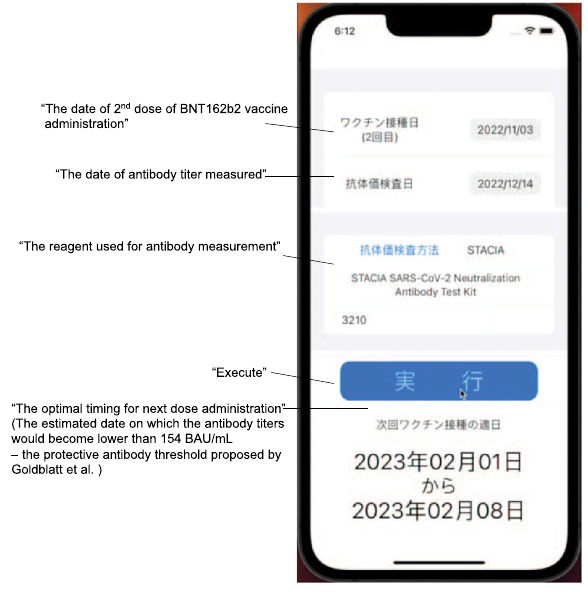
Fig. 4 Prototype of antibody simulation application using model. Screen image of the iOS application named “ COVID Vaccine Navi. ” Information about the date of vaccination singly measured antibody titer, and estimated date of negative seroconversion is presented. A demonstration video is available in the supplementary